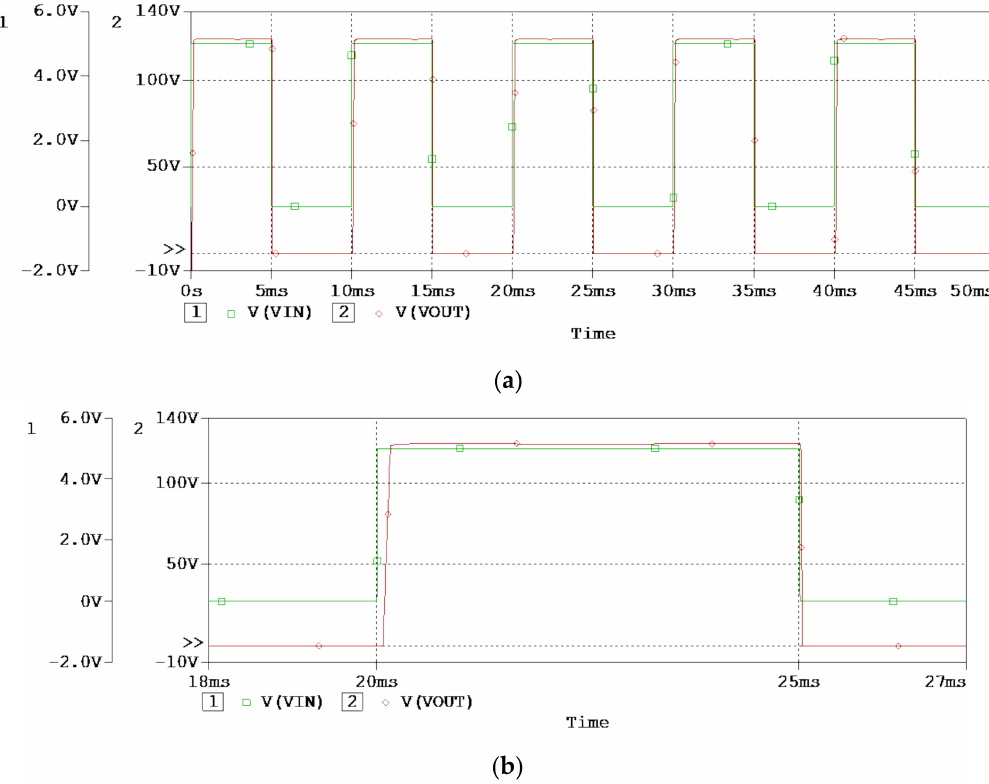
Figure 27. Simulated waveforms for the power amplifier using general operational amplifiers; ( a ) the overall perspective waveform; ( b ) the rising edge and the falling edge of the waveforms.